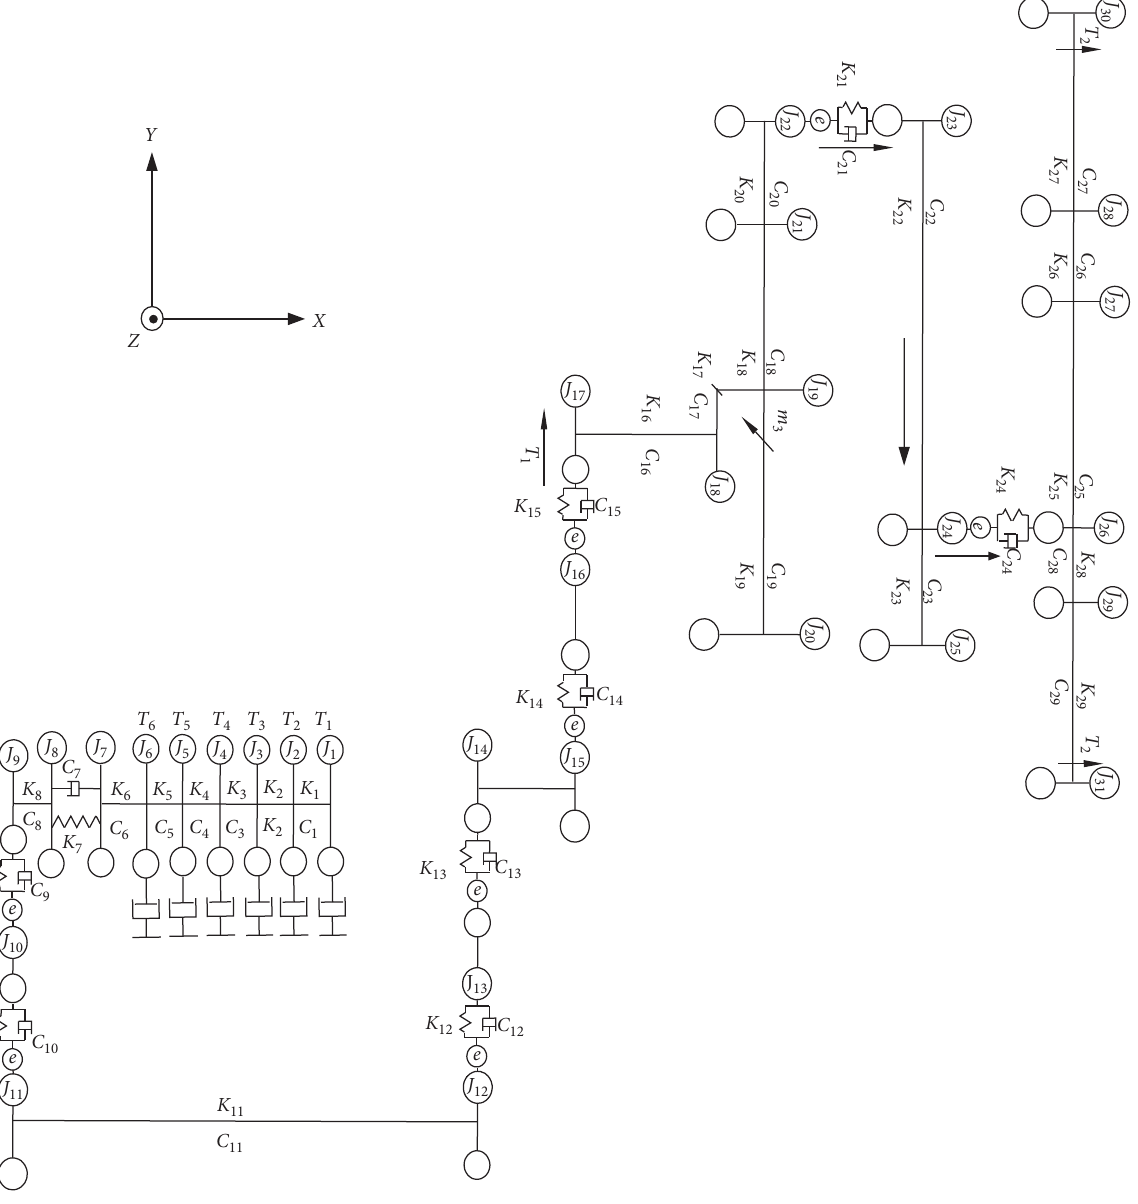
Figure 8: System torsional vibration dynamics model of the 6th